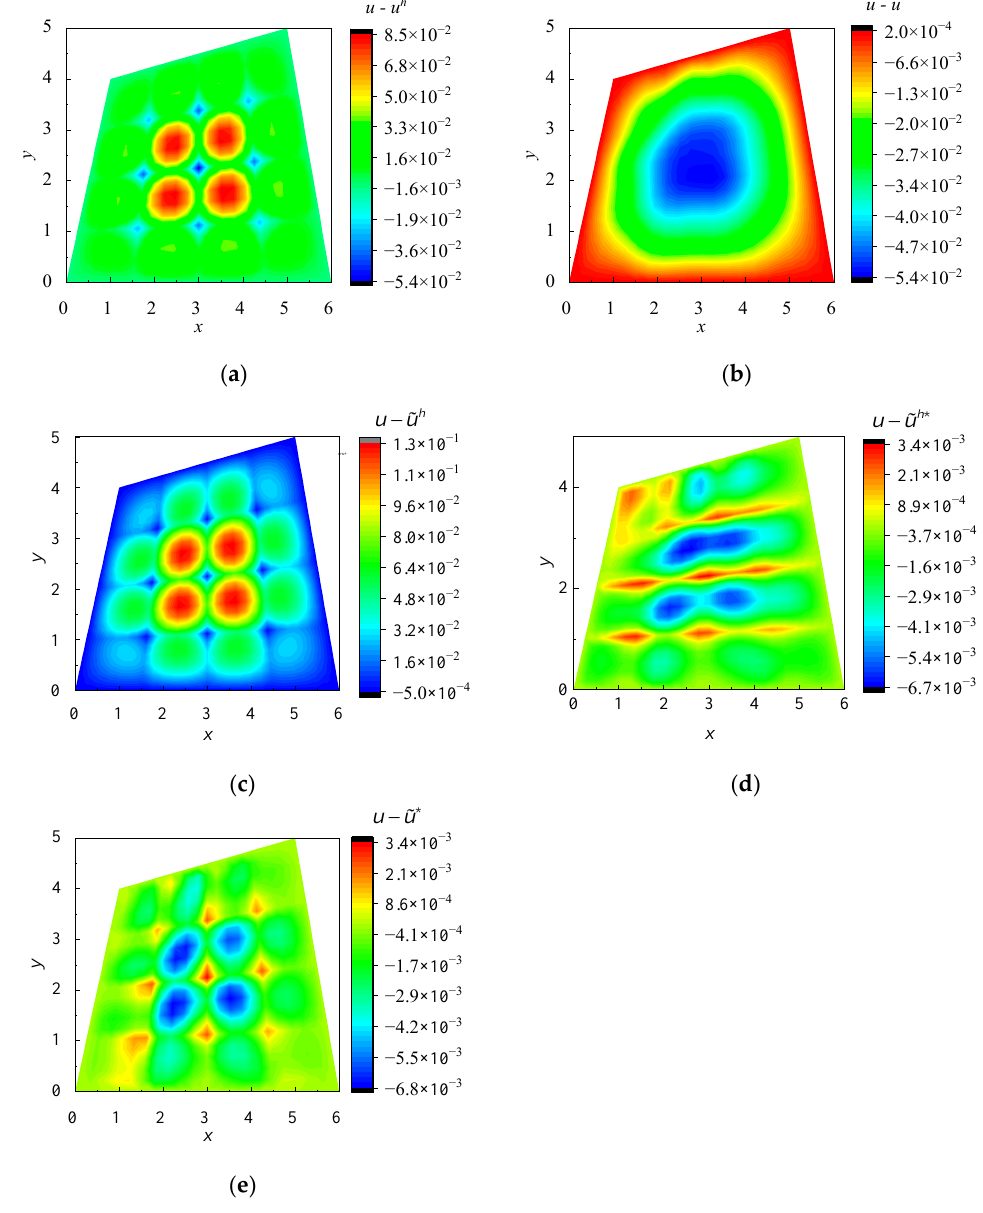
Figure 6. Error distributions of ( a ) FE solution u h ; ( b ) original EEP solution u ∗ ; ( c ) improved FE solution (cid:101) u h ; ( d ) EEP solution (cid:101) u h ∗ of (cid:101) u h ; ( e ) improved EEP solution (cid:101) u ∗